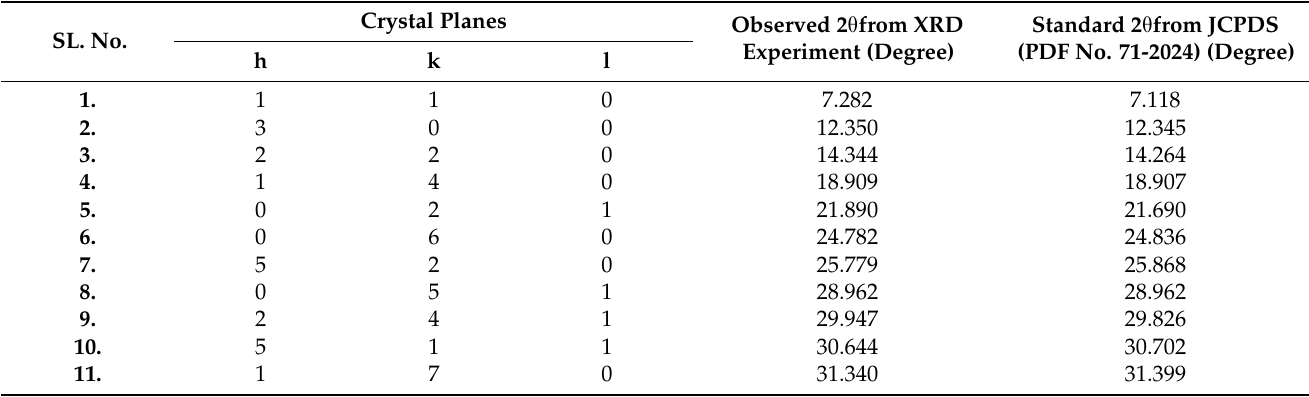
Figure 4. X-ray diffraction (XRD) pattern of prepared SbI 3 •3S 8 crystal. (The peaks are marked with crystal planes and below provide the JCPDS (PDF No. 71-2024) of SbI 3 •3S 8 crystal.)